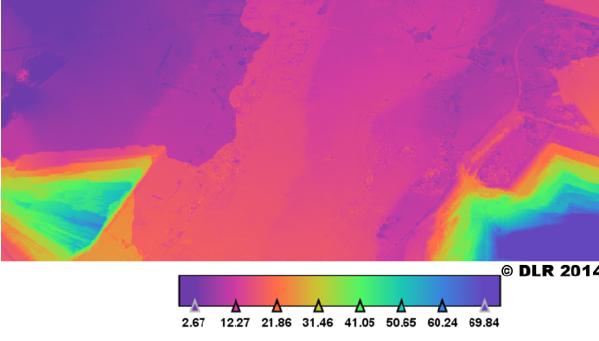
Figure 4. Unwrapped Phase generated from the TDM pair of July 15, 2014.